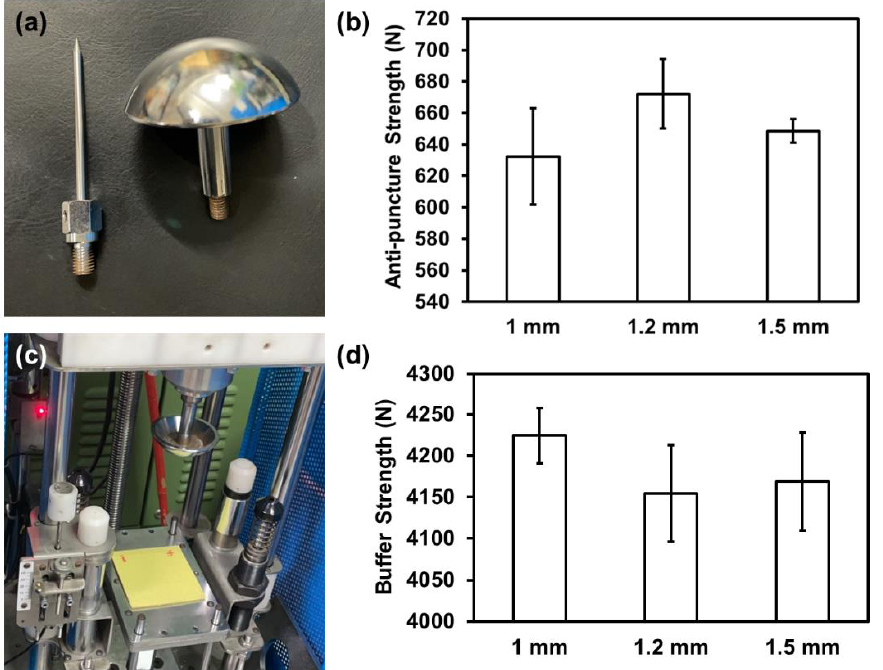
Figure 9. Anti-puncture and buffer strengths of Kevlar/TPU laminated composites as related to the thickness. ( a ) Test mold, ( b ) puncture test result, ( c ) impact device, ( d ) buffer test result